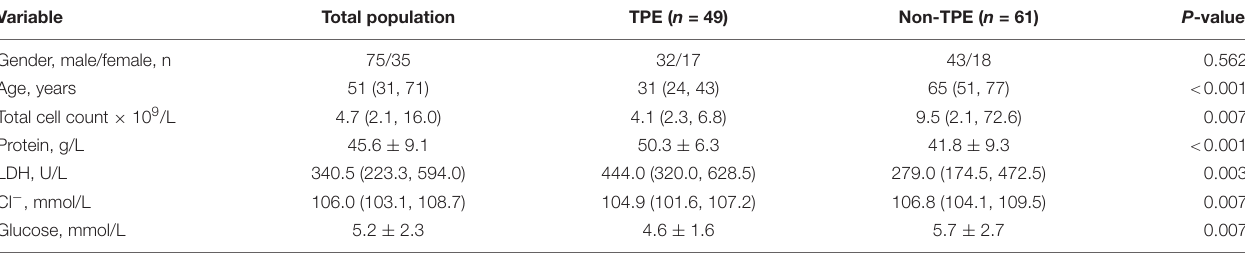
TABLE 1 | Baseline characteristics according to study population.